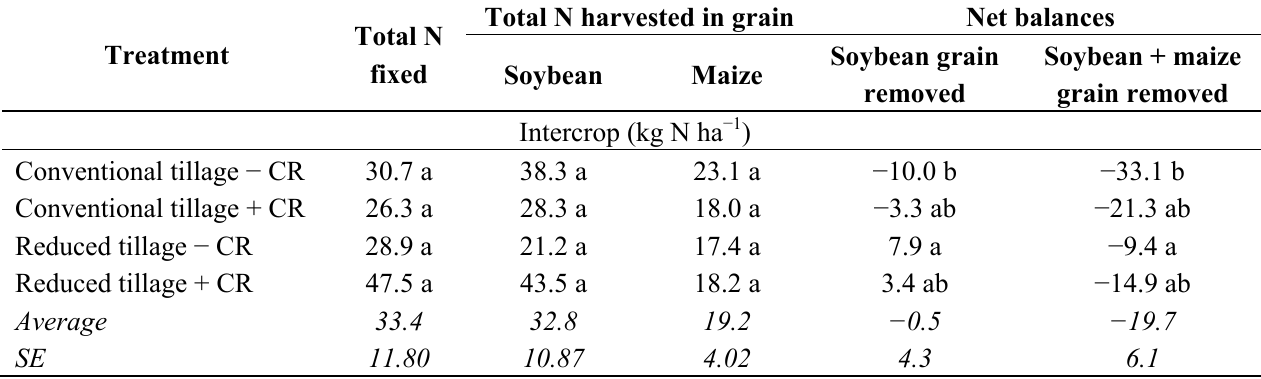
Table 6. Nitrogen balance in soybean-maize intercropping and rotation systems in Nyabeda, western Kenya, March–August 2007 cropping